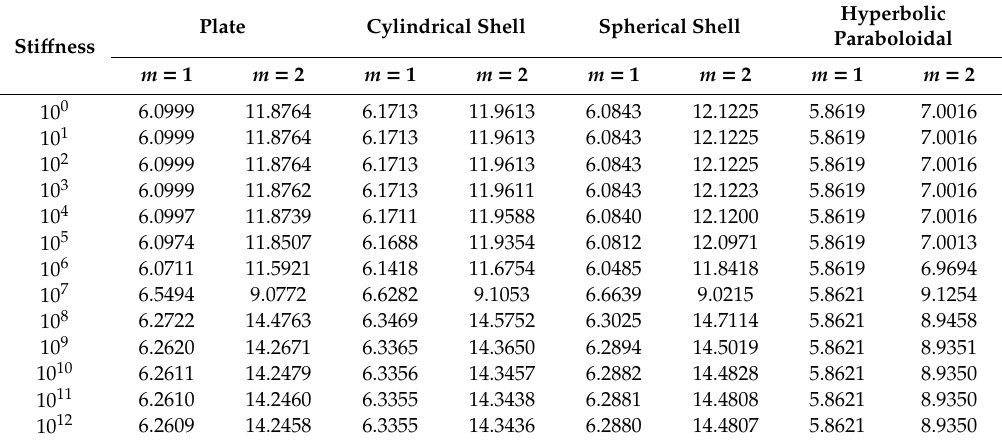
Table 15. The frequency parameter Ω for composite shallow [0 ◦ / 90 ◦ ] shells with S- K φ x boundary conditions by FSDT.